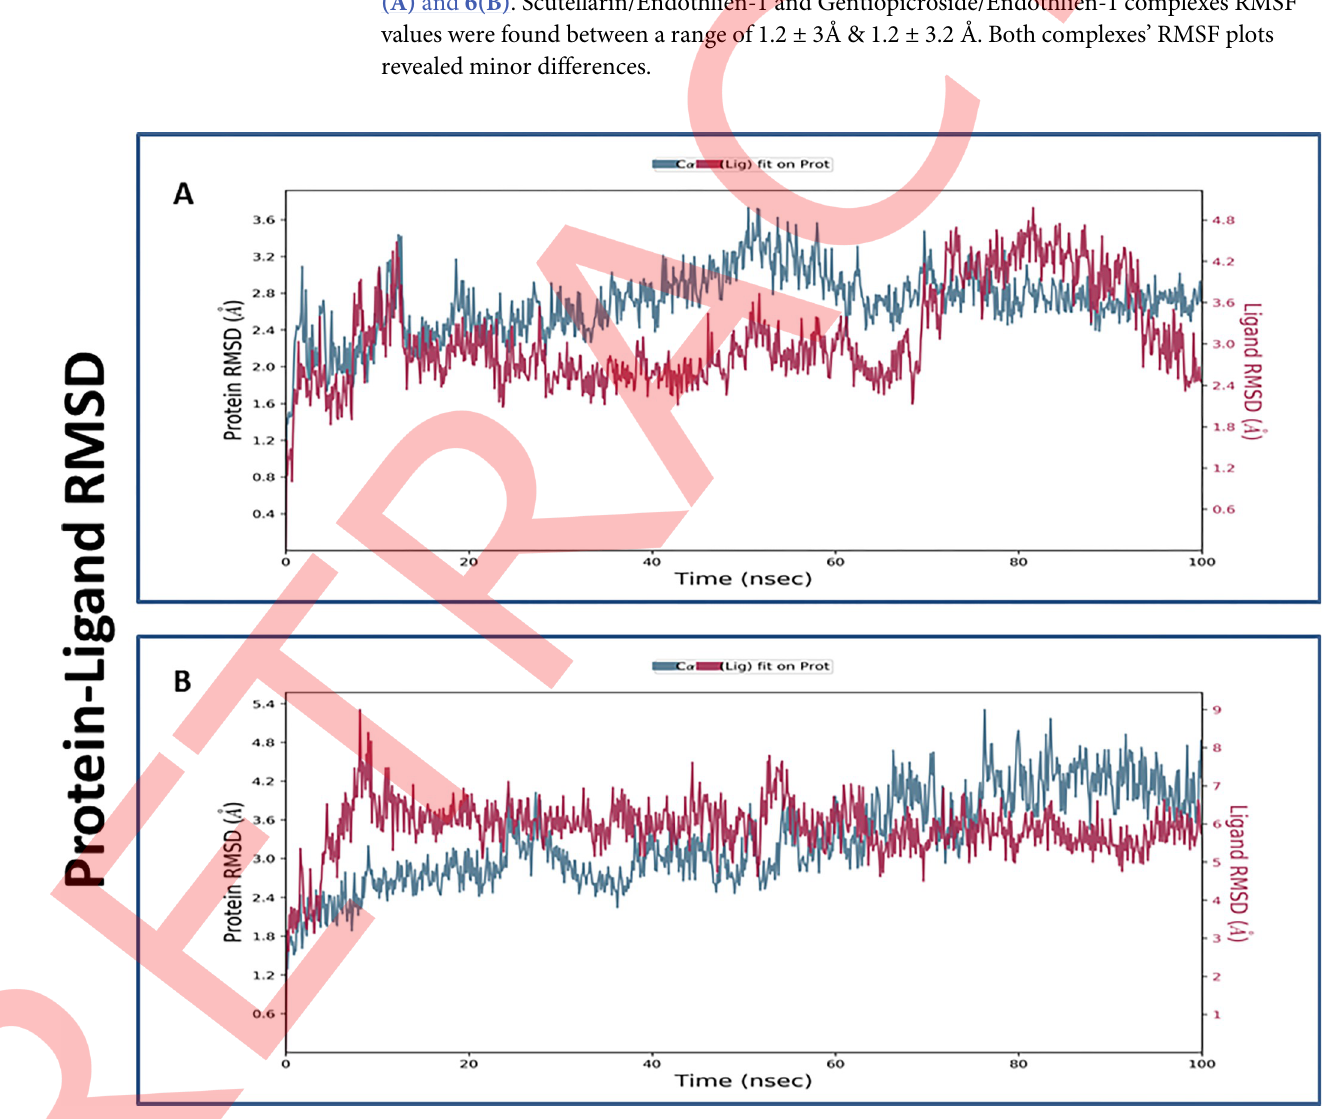
Fig 5. Detail representation of root mean square deviation plots of protein ligand complex.